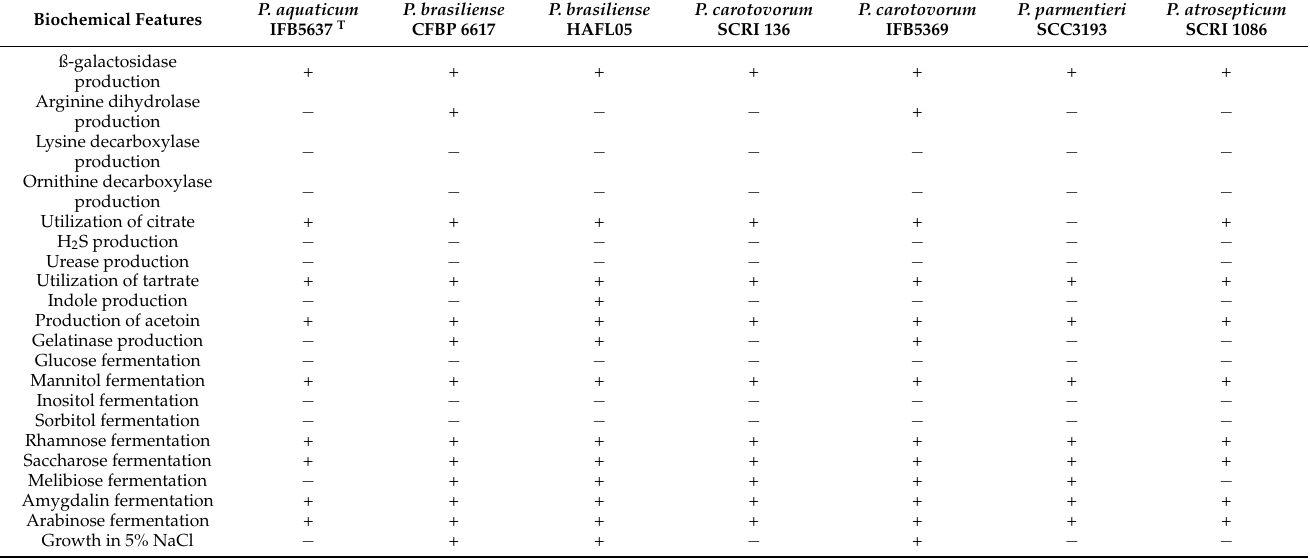
Table 3. Biochemical features of the P. aquaticum IFB5637 strain in comparison to the other tested Pectobacteriaceae strains. Biochemical